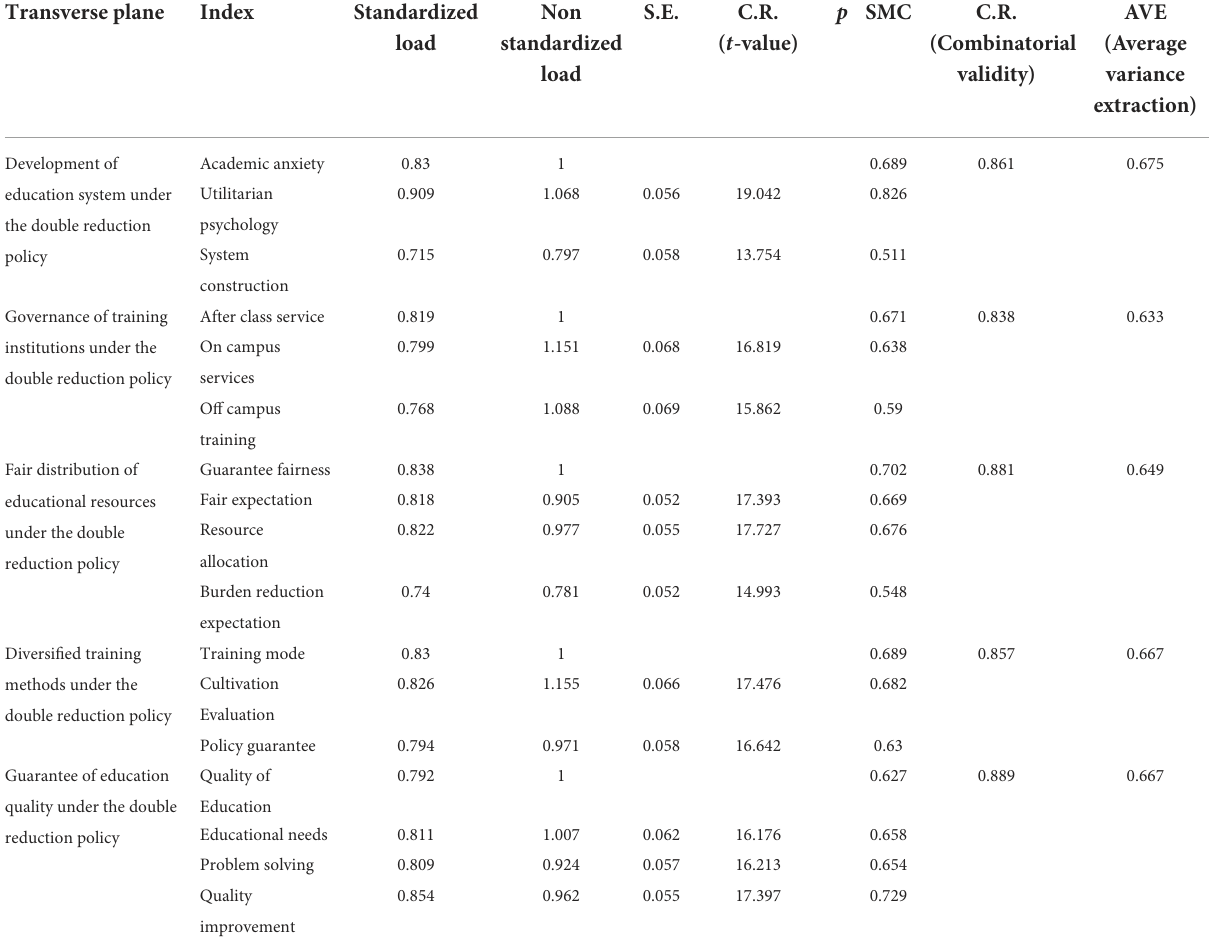
TABLE 16 Simulation fitting results of convergence